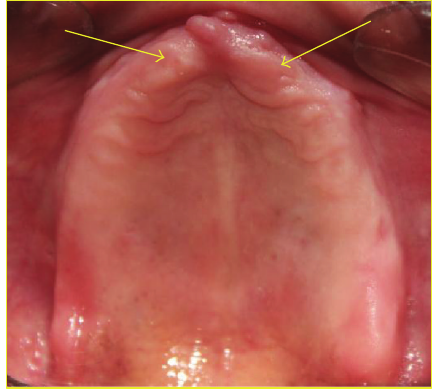
Figure 1: edentulous maxillary arch with arrows showing areas of flabby tissue.